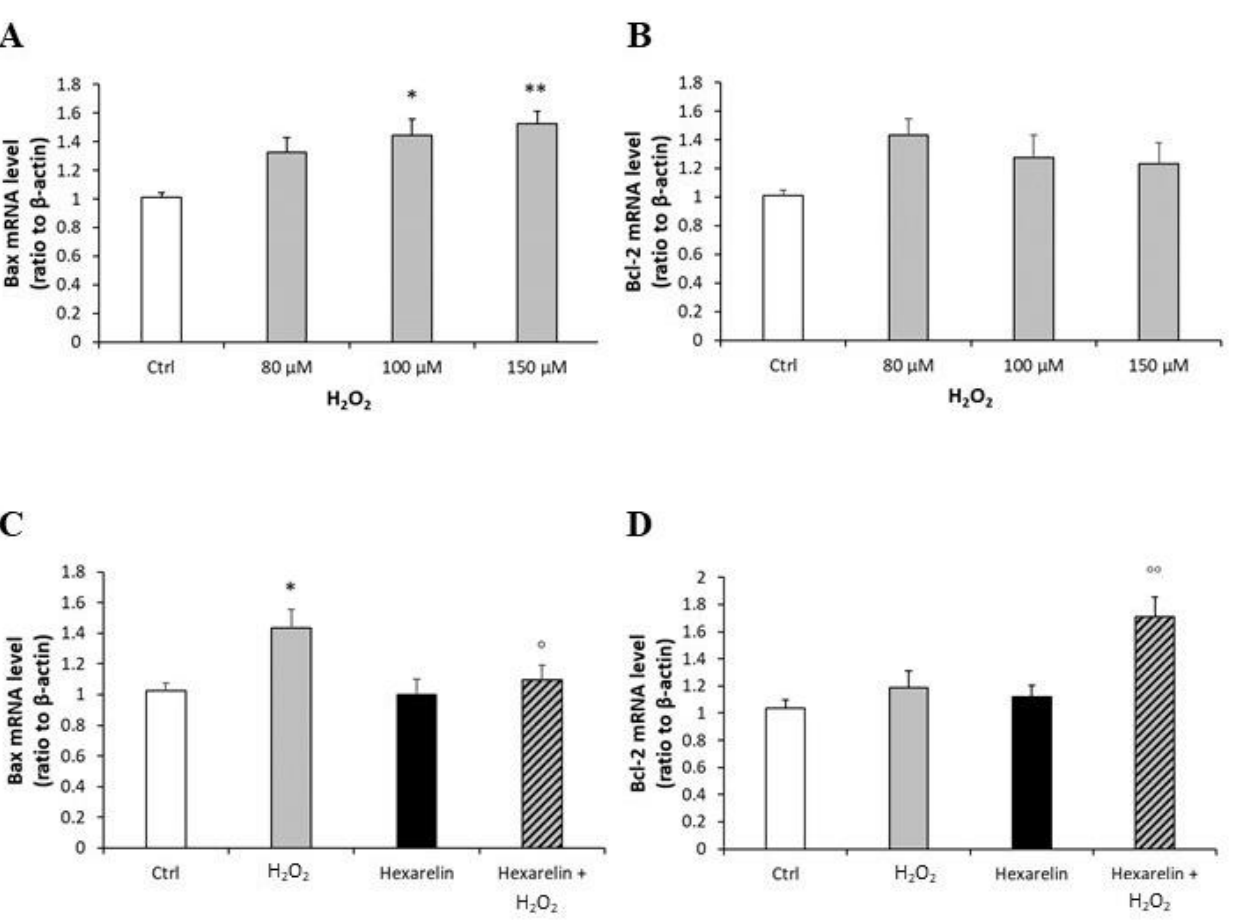
Figure 10. Analysis of mRNA levels of apoptosis markers following H 2 O 2 exposure and their modulation induced by hexarelin. Neuro-2A cells were treated with different concentrations of H 2 O 2 (80, 100, 150 µ M) or co-incubated with hexarelin 1 µ M and H 2 O 2 100 µ M for 24 h. Bax ( A , C ) and Bcl-2 ( B , D ) mRNA levels were normalized for the respective β -actin mRNA levels. Data are expressed as mean ± SEM of 3 replicates ( n = 18). * p < 0.05, ** p < 0.01 vs. CTRL; ◦ p < 0.05, ◦◦ p < 0.01 vs. H 2 O 2 .